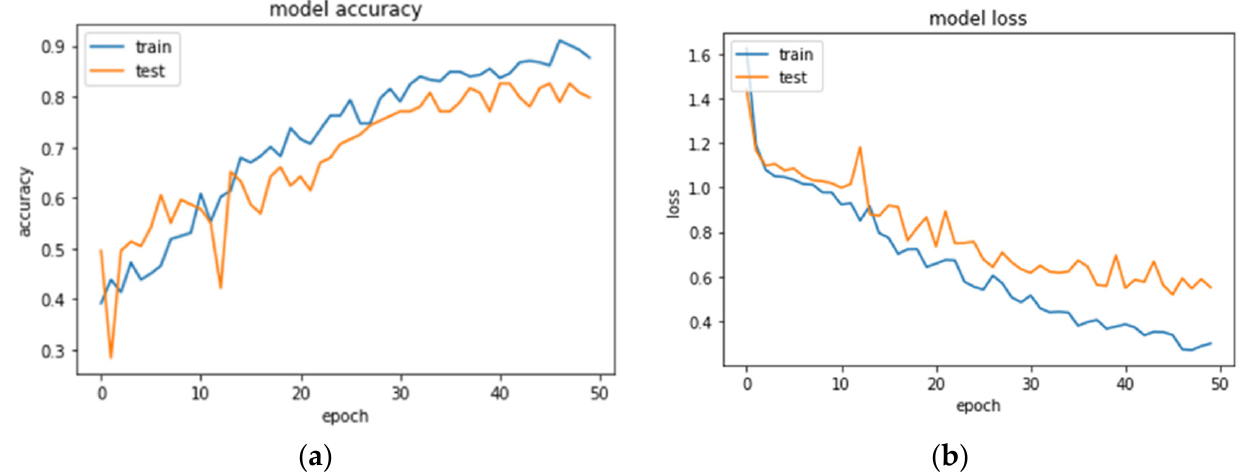
Figure 11. Training and testing of VGG16 + IDA model: ( a ) training and testing accuracy, ( b ) training and testing loss.